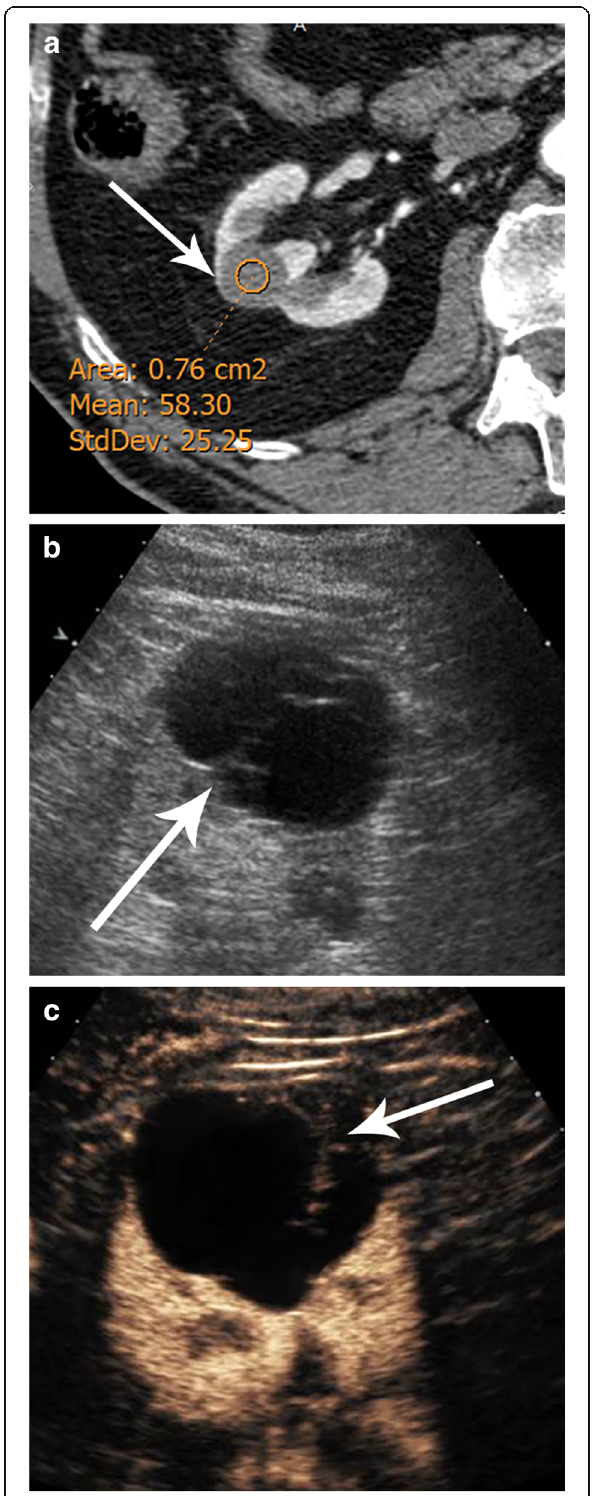
Fig. 4 Indeterminate renal mass by CT in the right kidney. a Axial CT in the arterial phase depicts a renal tumor with 58 HU consistent with the indeterminate lesion (arrow). b Unenhanced and ( c ) contrast-enhanced ultrasound (US) of the same renal tumor showing the presence of a cyst with thin septa with no contrast uptake corresponding to a Bosniak II lesion (arrow): follow-up